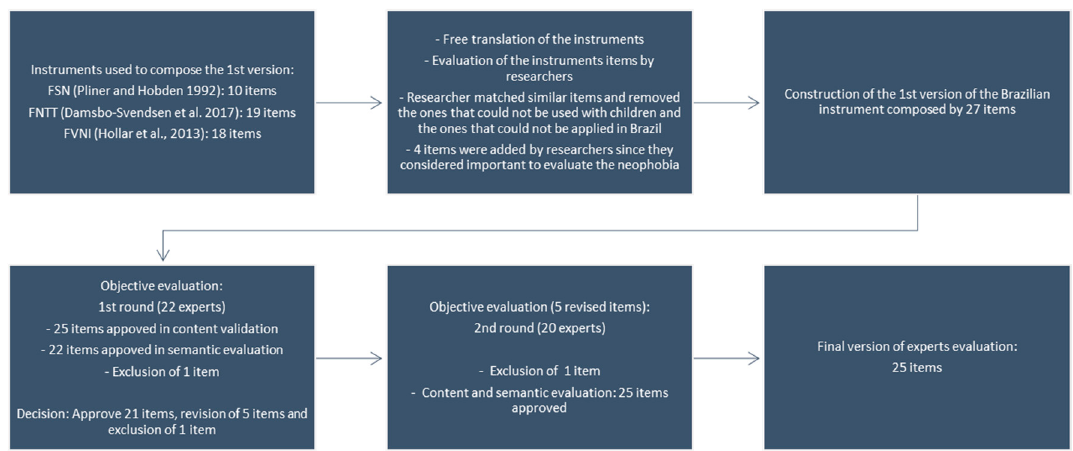
Figure 1. Summary of the construction, content validation and semantic evaluation process of the food neophobia instrument in children in Brazilian–Portuguese.